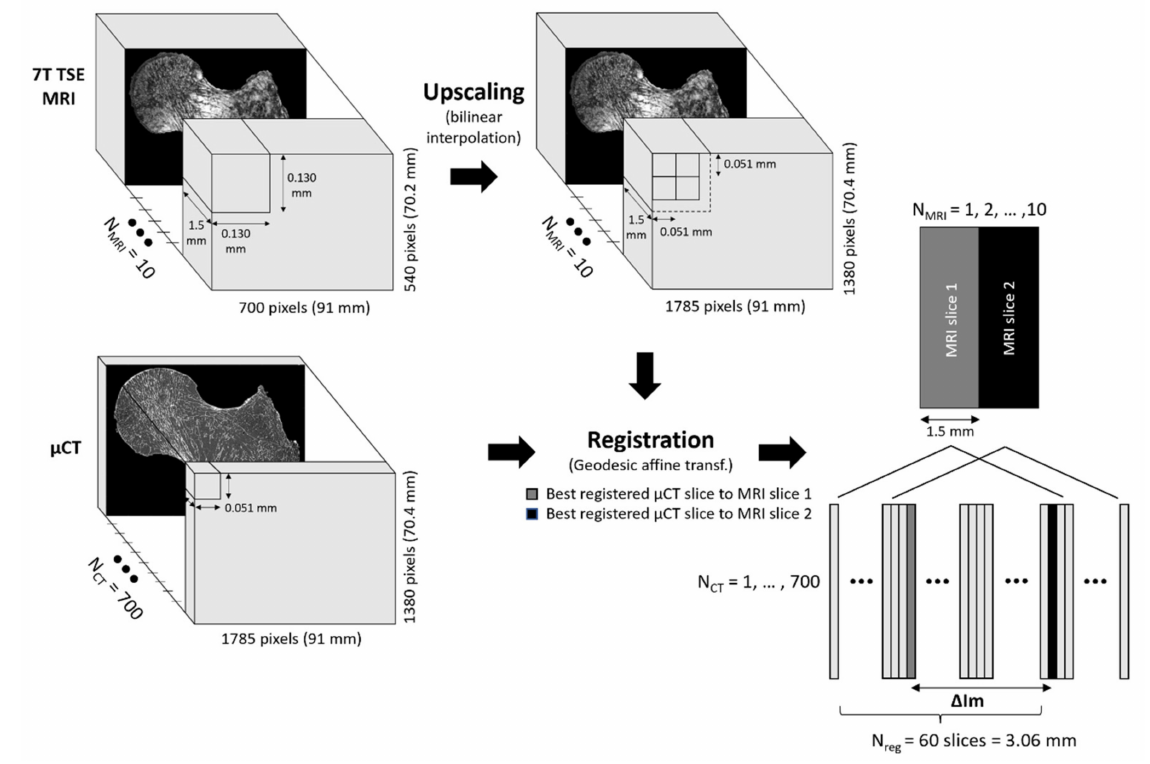
Figure 2. Registration